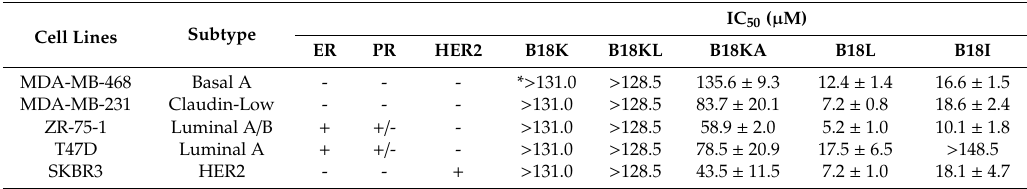
Table 2. Initial Screening Data on breast cancer cells for 24